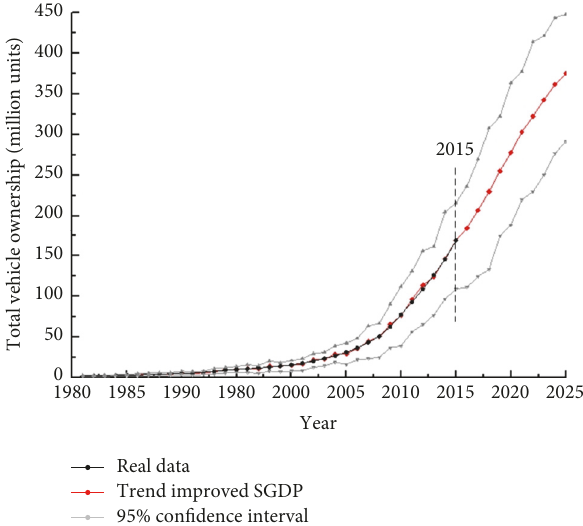
Figure 8: Projection of total vehicle ownership to 2025 in